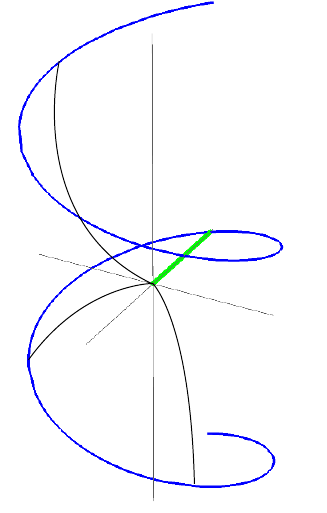
Figure 2 . Sketch of the one-parameter family of geodesics. The vertical axis is (cid:28) , the horizontal plane is described by the radius (cid:26) and the azimuthal angle (cid:18) , and the y direction is suppressed. The circuits which produce the transformation from A to A are described by geodesics running from R T the origin to the blue spiral at (cid:18) + (cid:28) = (cid:18) 1 + (cid:28) 1 and (cid:26) = (cid:26) 1 (shown here for the special case (cid:18) 1 + (cid:28) 1 = (cid:25) , which appears in eq. (3.48) below). The black curves represent (non-minimal) geodesics within the one-parameter family of solutions with di(cid:11)erent values of (cid:18) 0 . The minimum geodesic corresponds to the green line in the (cid:28) = 0 plane with (cid:1) (cid:18) = 0 (i.e., (cid:18) 0 = (cid:18) 1 ), whose length is given by eq.